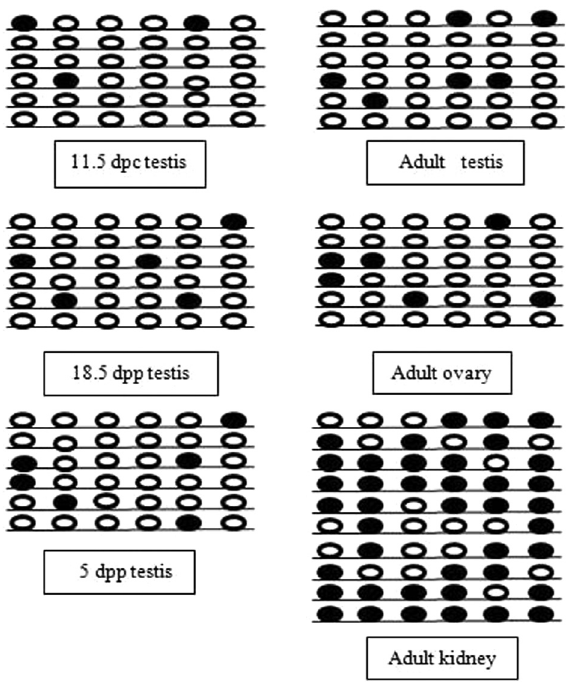
Figure 3 - Methylation mapping of 6 CpGs (1-145 bp) in 5’UTR region of Oct4 gene in testicular tissues at different stages of mouse development (11.5dpc,18.5dpc,5dpp,adulttestis,adultovaryandadultkidney).Each line represents individual clone harboring 6 CpG sites. Methylated and unmethylated CpGs are represented by dark circles and white circles re- spectively.